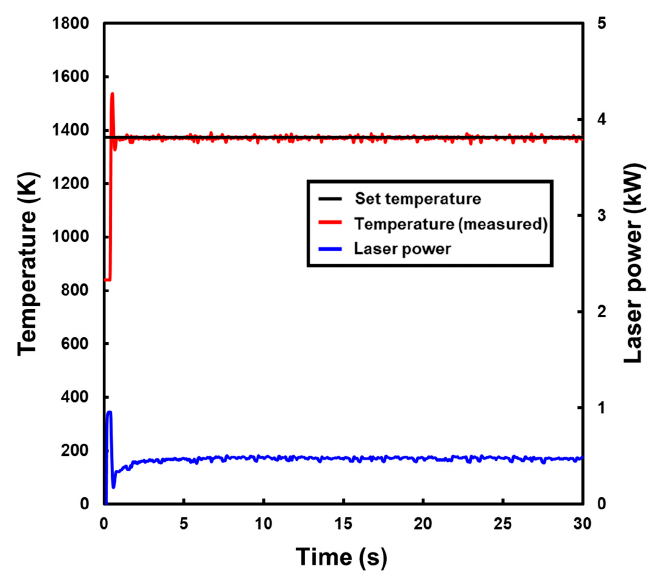
Figure 3. Laser power and temperature trends during laser-assisted fusing treatment of 1276F alloy (set temperature = 1373 K).